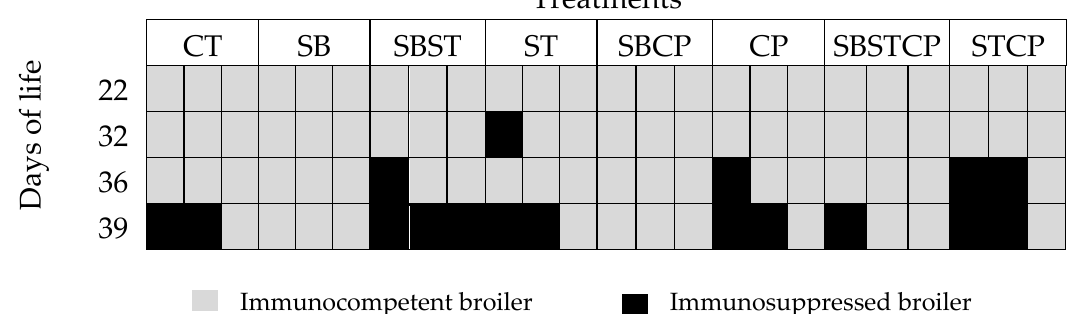
Figure 1. Bursa morphometric index in broilers treated with the synbiotic mix and inoculated with Salmonella typhimurium and Clostridium perfringens . CT — non-challenged control group; SB — synbiotic; SBST — synbiotic + S. typhimurium ; ST — S. typhimurium ; SBCP — synbiotic + C. perfringens; CP — C. perfringens; SBSTCP — synbiotic + S. typhimurium + C. perfringens; STCP — S. typhimurium + C. perfringens. Each square represents one broiler.